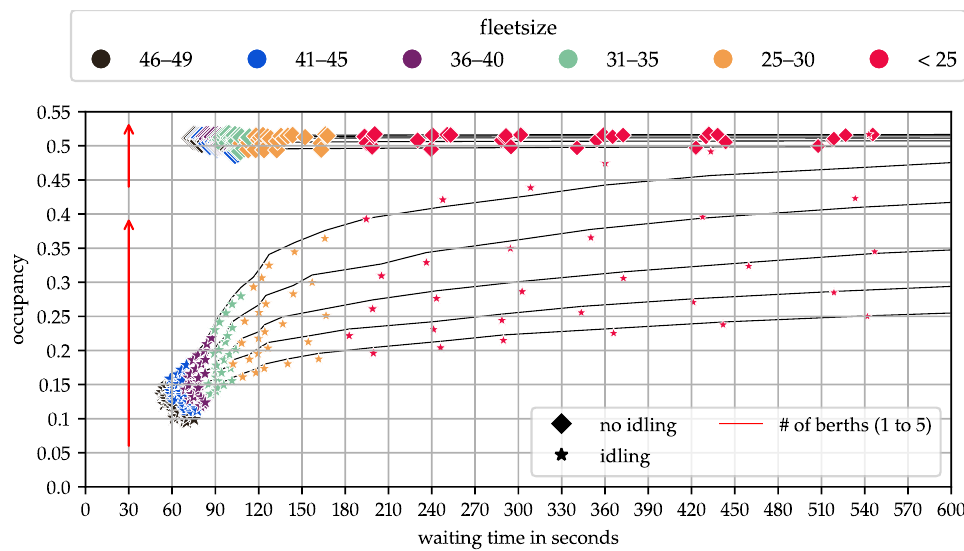
Figure 7. Occupancy of PRT systems with different numbers of berths, fleetsizes and grouped operating strategies.